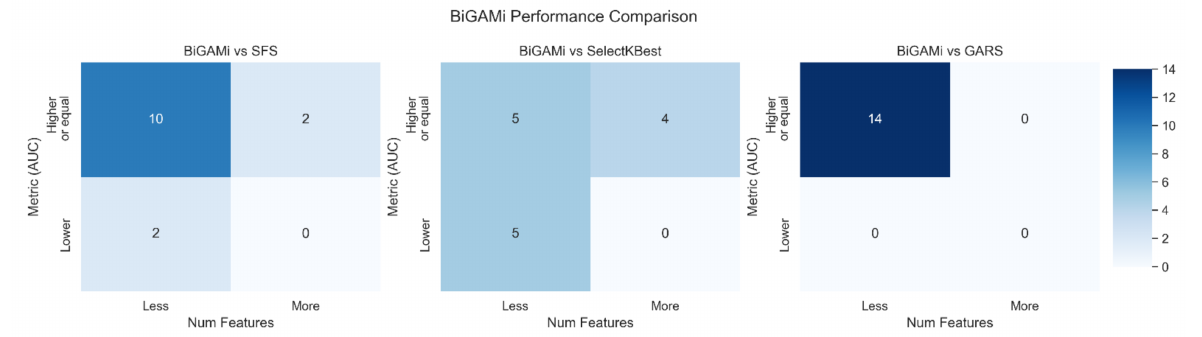
Figure 5. Performance comparison overview between BiGAMi, SFS, SelectKBest, and GARS. The upper left cells are preferred, indicating BiGAMi achieves a higher classification metric using a smaller feature